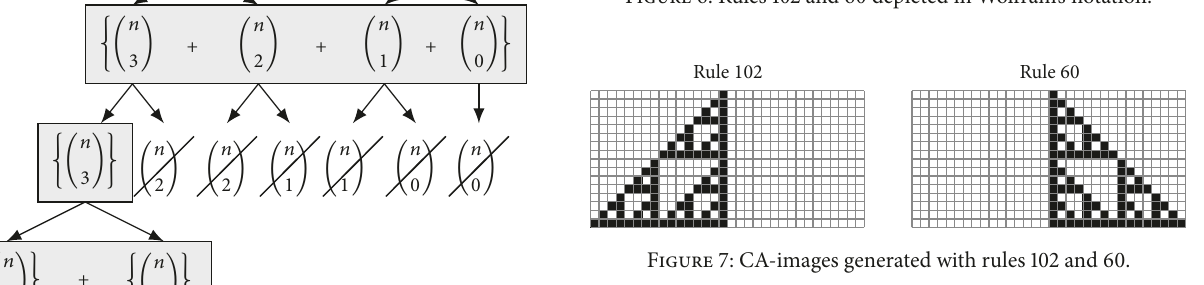
15 𝑐 {( 𝑛 )} , with 𝑐 𝑖 𝑖 𝑖=0